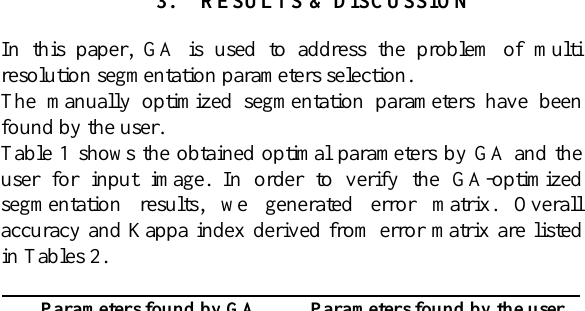
Figure 2. Pan-sharpened IKONOS image of Shiraz in Iran and its manually produced reference image 3.